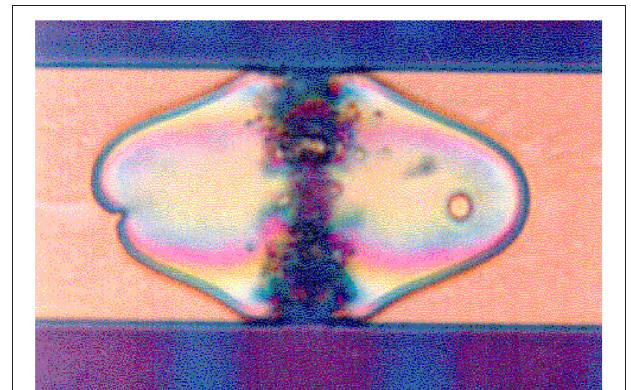
FIGURE 8 | Copper interconnect failure in first technology with Cu interconnects (with permission from the ESD Association).